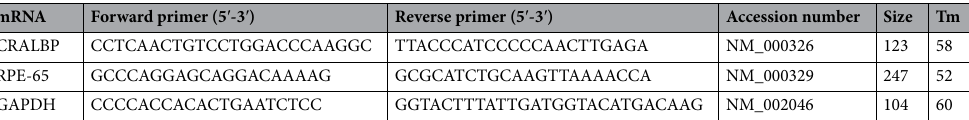
Table 1. PCR primer sequences used for